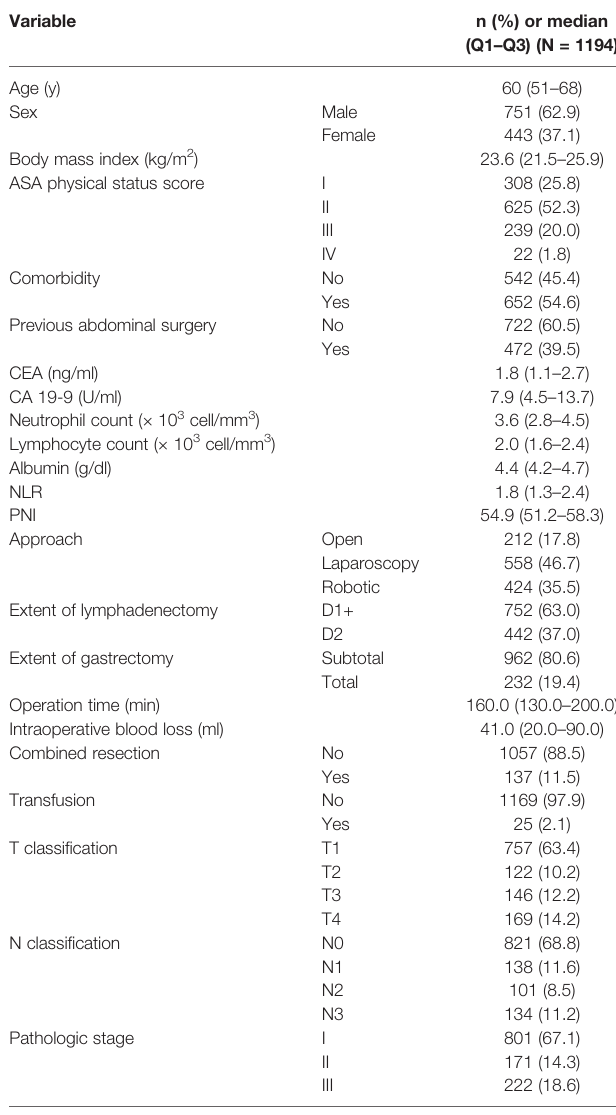
TABLE 1 | Clinicopathologic characteristics of all included